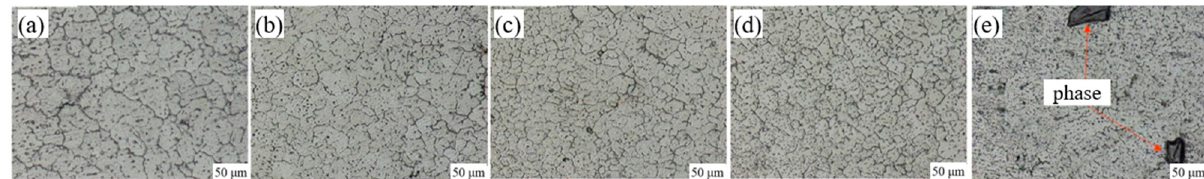
Figure 4. Microstructure of B 4 C particle with different deposition rates. ( a ) 120 mm/min, ( b ) 130